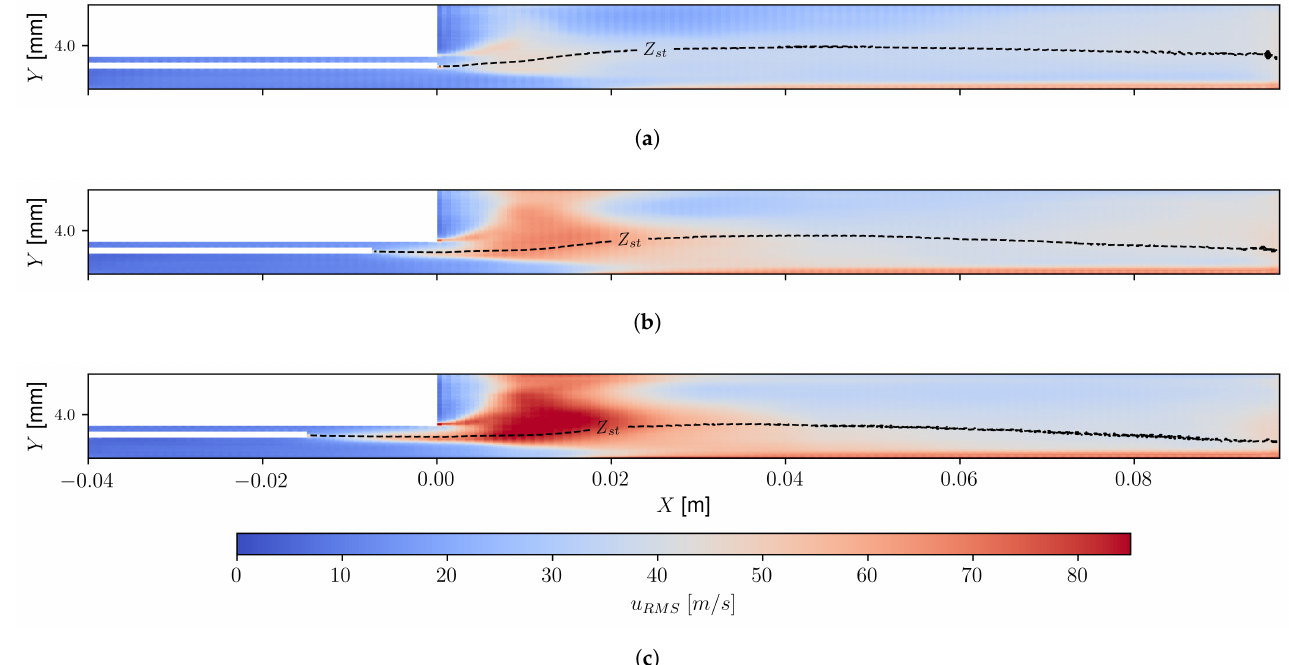
Figure 11. u RMS model’s prediction for: ( a ) DP-A, ( b ) DP-B, and ( c ) DP-C. The stoichiometric line, denoted by Z st , as estimated by Ξ , has been overlaid on top. The aspect ratio of the figures has been modified purposely to facilitate their